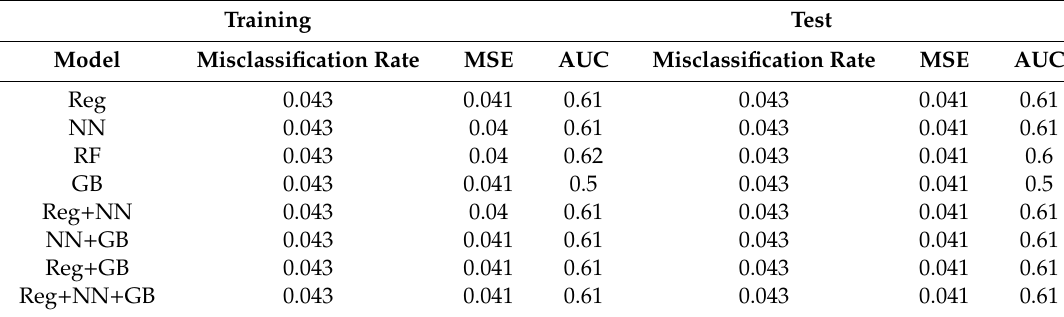
Table 18. Results for training and test